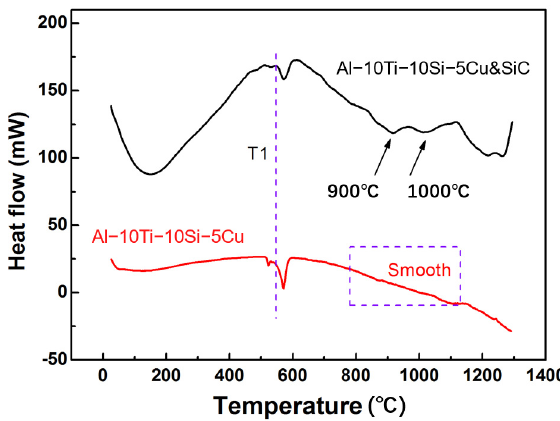
Figure 7. DSC analyses of mixtures of Al base alloy and SiC ceramic.